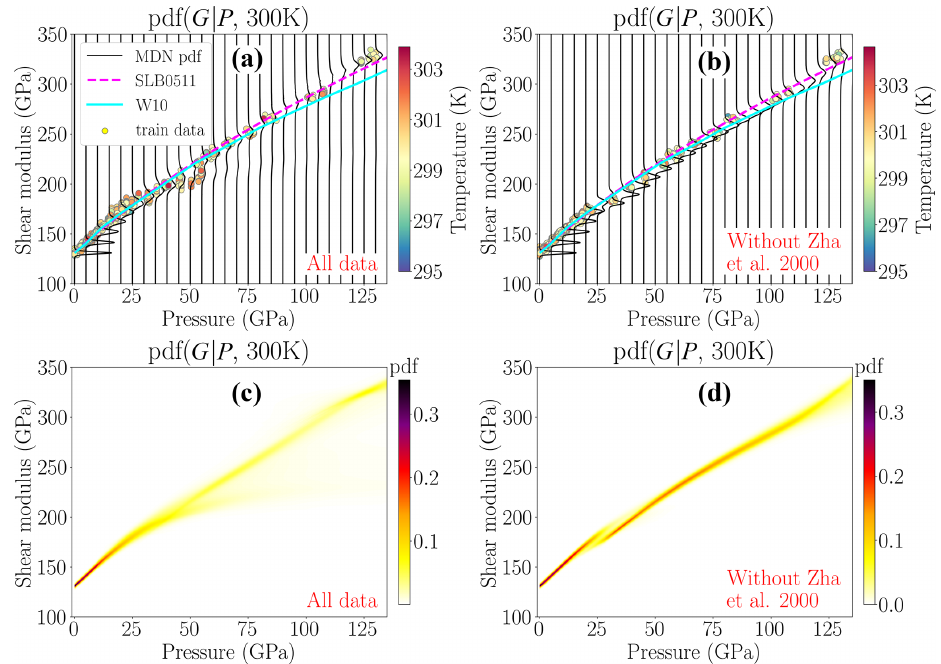
Figure 3. MDN-predicted pdf’s for the shear modulus of MgO at every 5GPa interval (a, b) and as a continuous function of pressure (c, d) . A sub-set of the total data, namely those data from the 295 to 305K (see colour bars) interval, are also shown as circles. Whilst (a) and (c) show predictions from the MDN trained with all data considered in this study, (b) and (d) are from the MDN trained without Zha et al. (2000). For comparison we show EOSs of Stixrude and Lithgow-Bertelloni (2005, 2011) and Wentzcovitch et al. (2010b), denoted as SLB0511 and W10, respectively. Experimental data from Murakami et al. (2009) largely control the MDN predictions in the high-pressure region, although a different trend of Zha et al. (2000) makes the posterior uncertainties larger around 50GPa. The effect of Zha et al. (2000) decreases as the pressure increases.